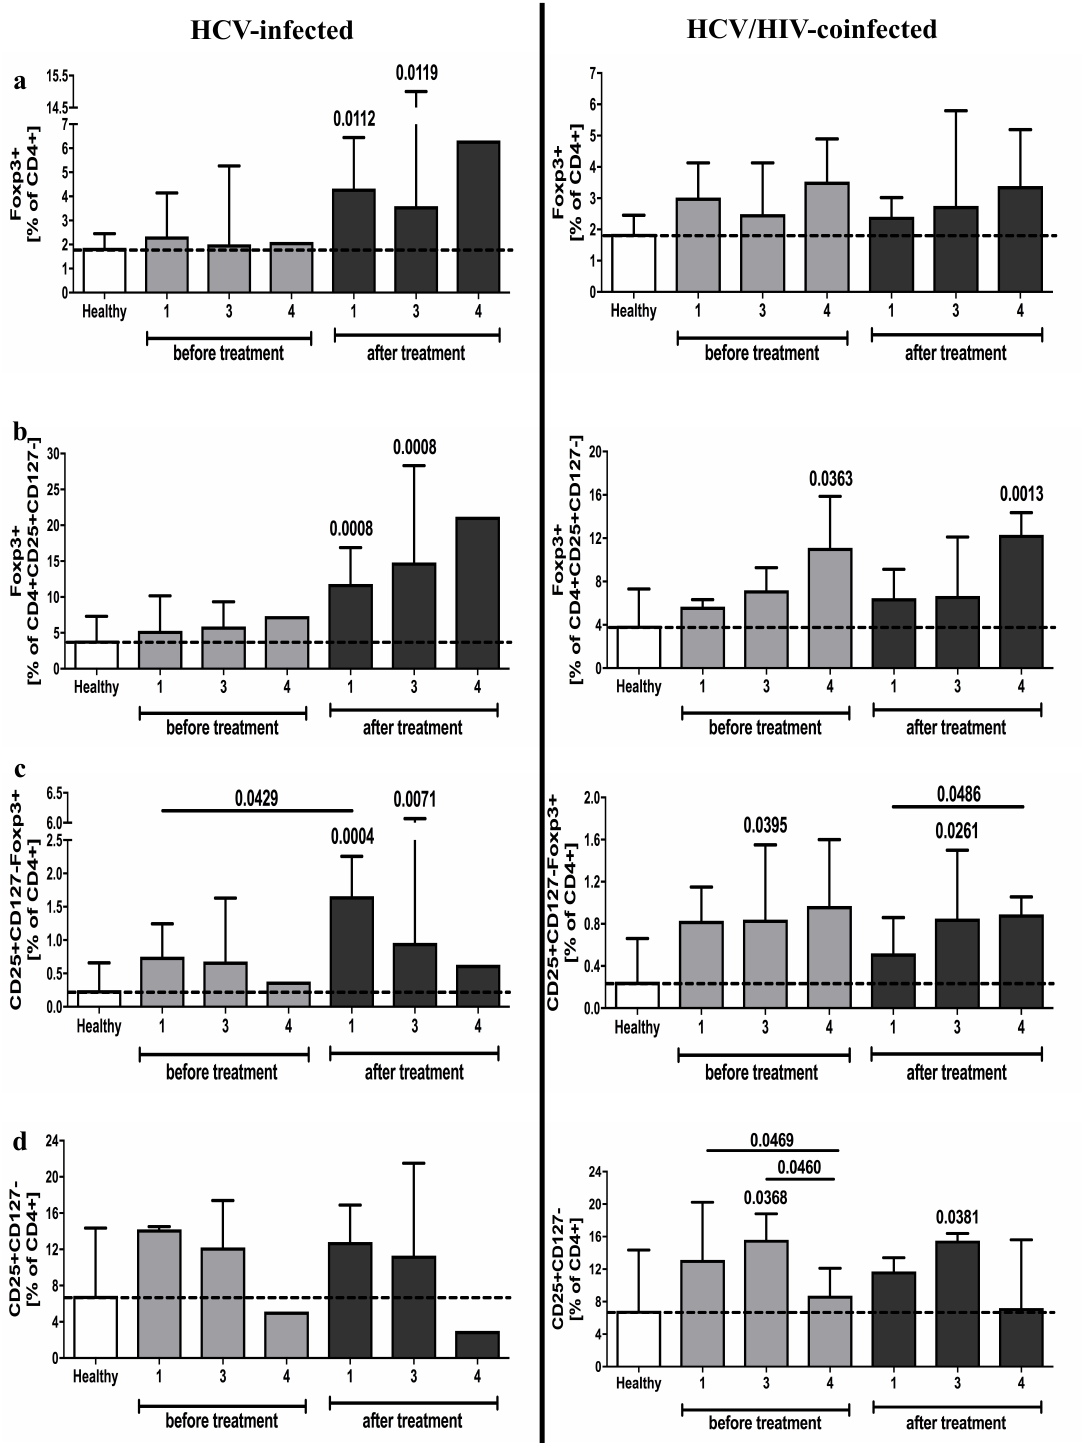
Figure 5. HCV virus genotype-related differences in regulatory T cells frequencies in response to anti-viral therapy in HCV-infected (left column) and HCV/HIV-coinfected patients (right column). Data related to T regs in HCV or HCV/HIV- coinfected patients presented as: Foxp3 + in CD4 + ( a ) and CD4 + CD25 + CD127 − ( b ) lymphocytes, CD25 + CD127 − Foxp3 + ( c ) and CD25 + CD127 − ( d ) within CD4 + T cell pool. Significant changes in relation to healthy controls indicated directly above specific group column; additional differences distinguished with